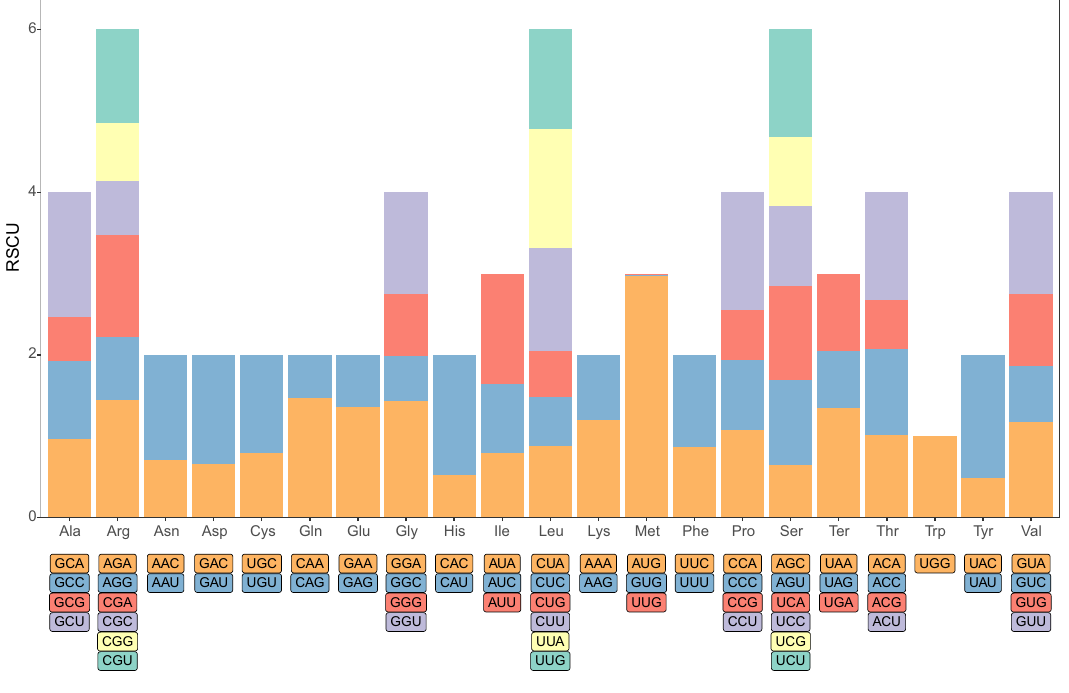
Figure 8. Relative synonymous codon usage in the P. serratifolia mitogenome.